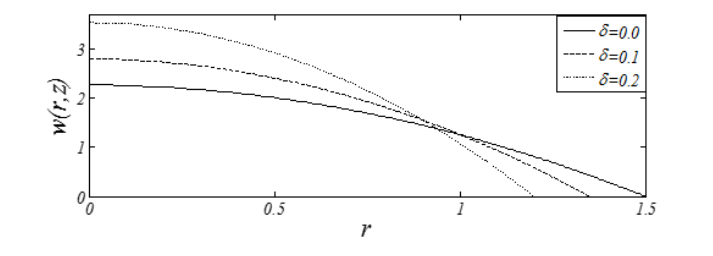
Fig. 4 Velocity variation for F=2, n=2, a=0.2, b=0.4, m=1.1.